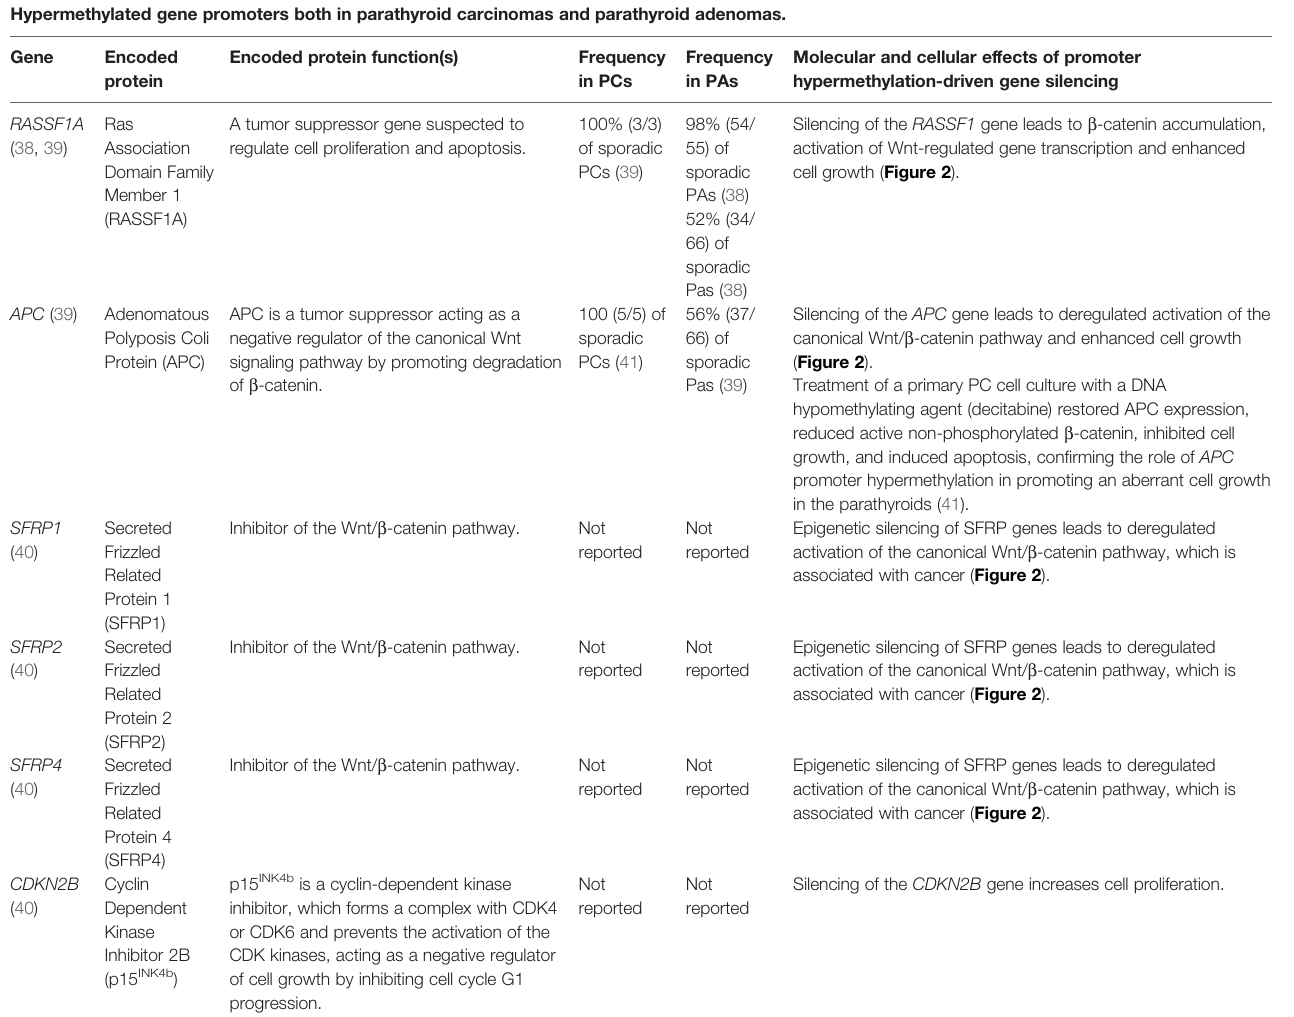
Molecular and cellular effects of in PCs promoter hypermethylation-driven gene